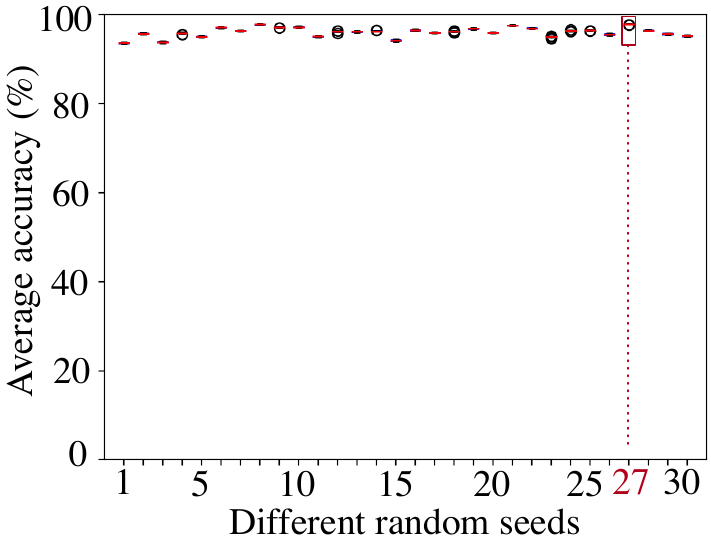
Figure 17. The effect of initial weights (generated from different random generator seeds) on the classification accuracy of